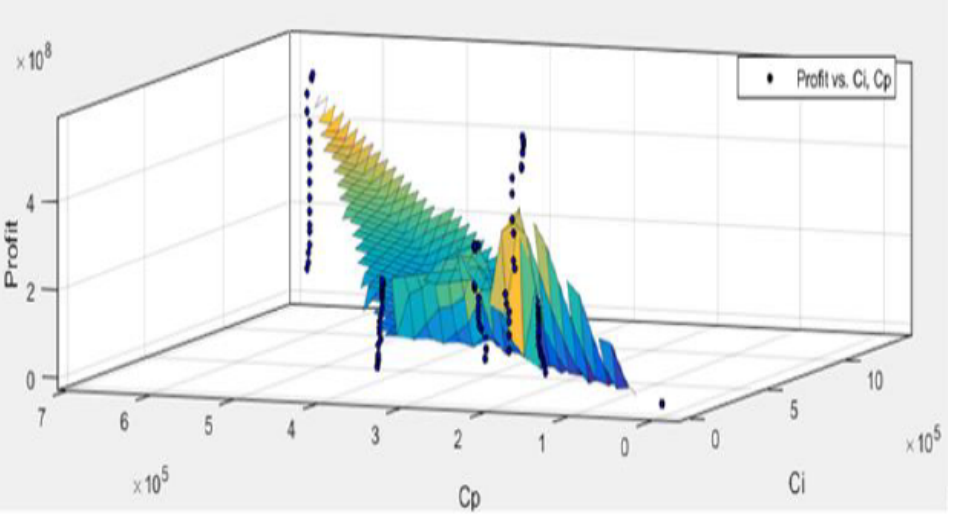
Figure 6. The curves of correlation between idea cost and production cost in dynamic SMES.